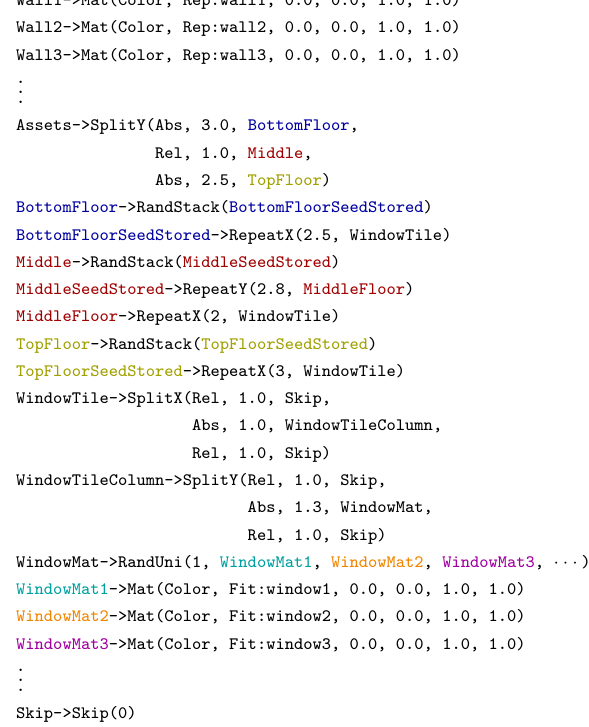
Figure 12: This example grammar was used for one of our perfor- mance tests using a stochastic rule selection. Possible outcomes of this particular grammar can be seen in Figure 13.b. The gen- erated structure is similar to the one depicted in Figure 6. There- fore, the chosen color coding of the rules corresponds to the scope colors in Figure 6. Constants like Color , Fit , Abs or the texture names are automatically mapped when the grammar is compiled.